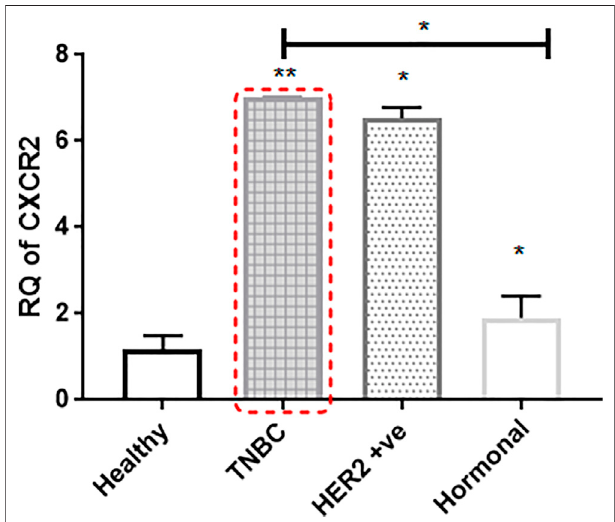
FIGURE 1 | CXCR2 expression is upregulated in the tumor tissue of breast cancer patients. Expression of CXCR2 in different subtypes of BC tissue is compared to the expression in adjacent normal tissue ( n = 22). RNA was prepared from whole targeted biopsies post resection and from adjacent normal breast tissue to perform RT-PCR experiment. p values; unpaired Student ’ s